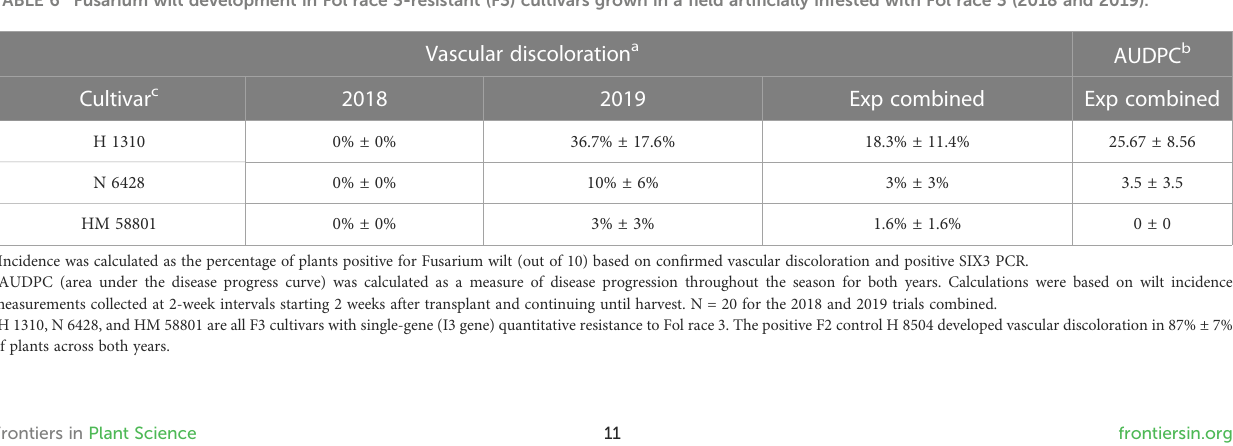
TABLE 6 Fusarium wilt development in Fol race 3-resistant (F3) cultivars grown in a fi eld arti fi cially infested with Fol race 3 (2018 and